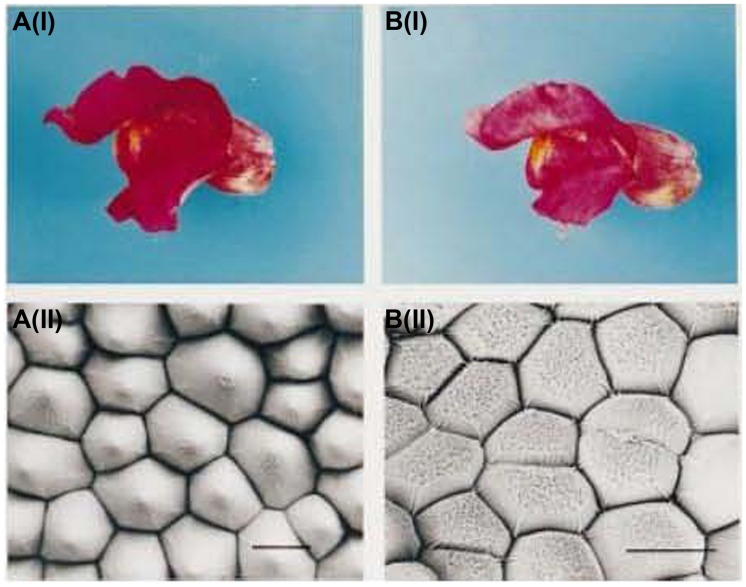
Petal color and scanning electron micrograph of snapdragon and its mutant (Noda et al., 1994). A(i) Wild-type flower with magenta petals; A(ii) Scanning electron micrograph of wild-type petal; B(i) Mutant flower with pink petals; B(ii); Scanning electron micrograph of a mutant petal.